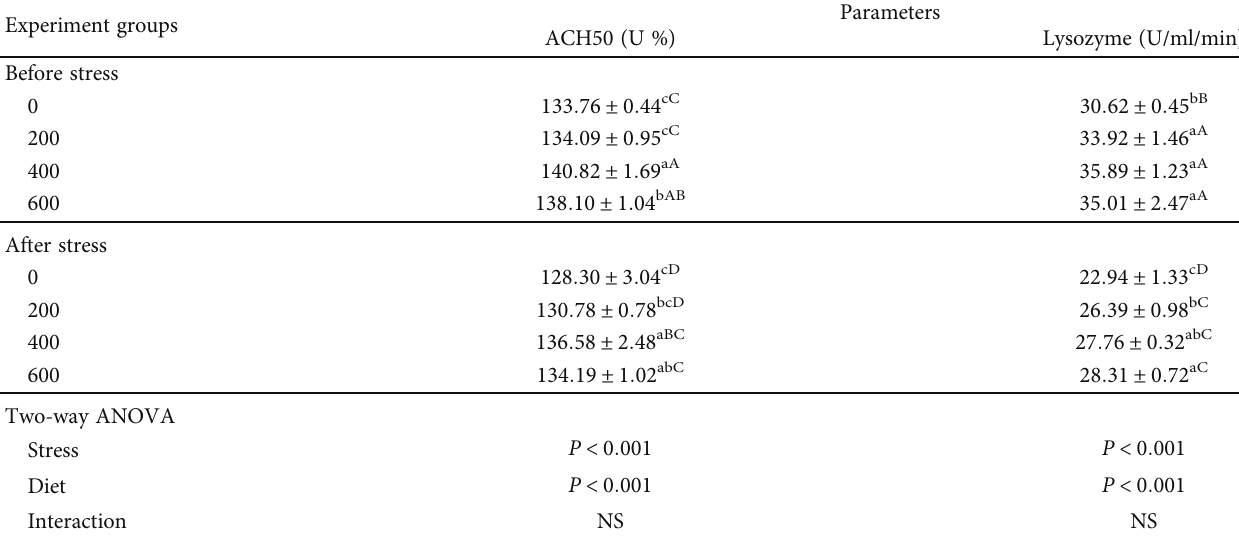
Table 4: Immune response of common carp fed di ff erent levels of quercetin for 60 days before and after heat stress. Experiment groups